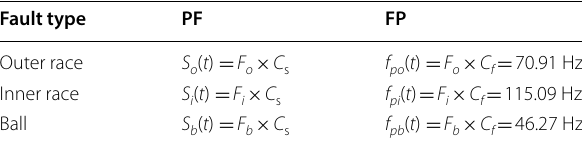
Table 3 PFs and FPs under outer race fault